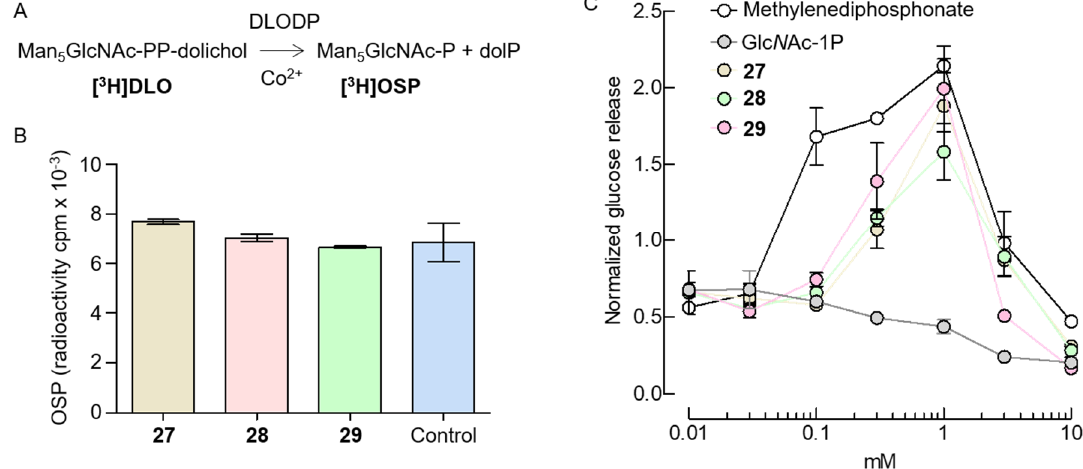
Figure 6. Evaluation of the capacity of compounds to inhibit DLO diphosphatase and alkaline phosphatase. ( A ) Dolichol linked oligosaccharides (DLO) are hydrolysed by oligosaccharyl diphosphodolichol diphosphatase (DLODP) to yield oligosaccharyl phosphates (OSP) and dolichyl phosphate (dolP). ( B ) DLODP activity was measured, as detailed in Methods, in the presence of 1 mM 27 , 28 , and 29 ( n = 2, mean +/S.D.). ( C ) Alkaline phosphatase was assayed by quantitating the dephosphorylation of [ 3 H]Glc-1P as described in Methods. Compounds 27 , 28 , and 29 (as well as sodium methylenediphosphonate and Glc N Ac-1-phosphate (Glc N Ac-1P) were included in incubation mixtures at the indicated concentrations. Alkaline phosphatase activity is expressed as a fraction of that observed in control incubations conducted in the absence of added compounds ( n = 2, mean +/S.D.).